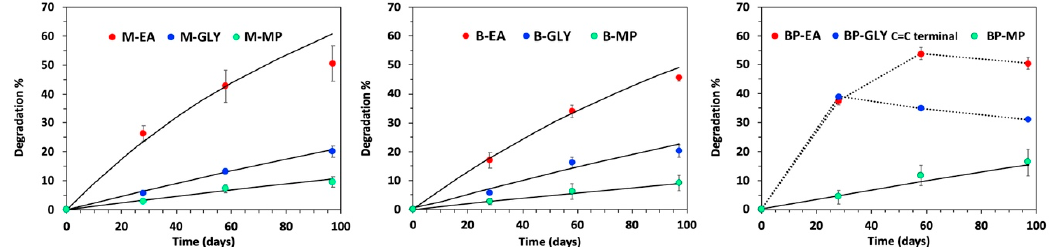
Figure 4. Degradation kinetics of PAAs at pH 7.0 and 25 ◦ C. Concentration of the repeat unit 43.6 µ M. Each panel shows the degradation curves relative to polymers obtained from the same bisacrylamide. The solid circles, with the related error bars, represent the experimental data determined as the averages of the values obtained considering different terminal- and internal repeat unit reference peaks (see also the captions to Figures 2 and S12–S19). The continuous lines are the fitting curves calculated by using the first order kinetic constants of Table 5. The dotted lines (BP-EA and BP-GLY) refer to trendlines not following first order kinetics. Figure 5. Degradation kinetics of linear PAAs at pH 9.0 and 25 °C. Concentration of the repeat unit 43.6 μ M. Each panel groups the degradation curves relative to polymers obtained from the same bisacrylamide. The solid circles, with the related error bars, represent the experimental data determined as the averages of the values obtained considering different terminal- and internal repeat unit reference peaks (see also the captions to Figures 3 and S20–S27). The continuous lines are the fitting curves calculated by using the first order kinetic constants of Table 5. The dotted lines refer to trendlines not following first order kinetics. 3.2.2. Degradation of M-GLY at 50 °C It is well known that the activation energy of the reverse aza-Michael reaction is higher than that of the direct reaction [36]. Therefore, it could be expected that higher temperatures would speed up the degradation reaction. This was investigated with a spot-wise experiment carried out with M-GLY at pH 9.0 and 50 °C. It was observed that the NMR spectra of the degrading M-GLY at pH 9.0 and 50 °C (Figure S28) did not significantly differ from those recorded at the same pH and 25 °C (Figure 3), confirming that the nature of the degradation products was similar in both cases. The results of the experiment at 50 °C compared with those obtained at 25 °C (Figure 6) suggested that at 50 °C the retro-aza-Michael reaction started considerably faster, but at longer reaction times apparently receded. This is in line with the occurrence of a hydrolytic degradation that was, of course, favored by the higher temperature.